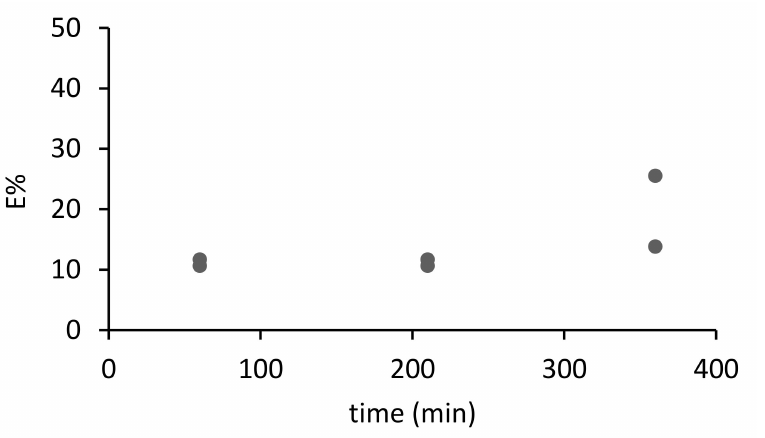
Figure 7. Kinetics of sorption of phosphate (1 mg L − 1 P) with M1 in SNW ( n = 2)